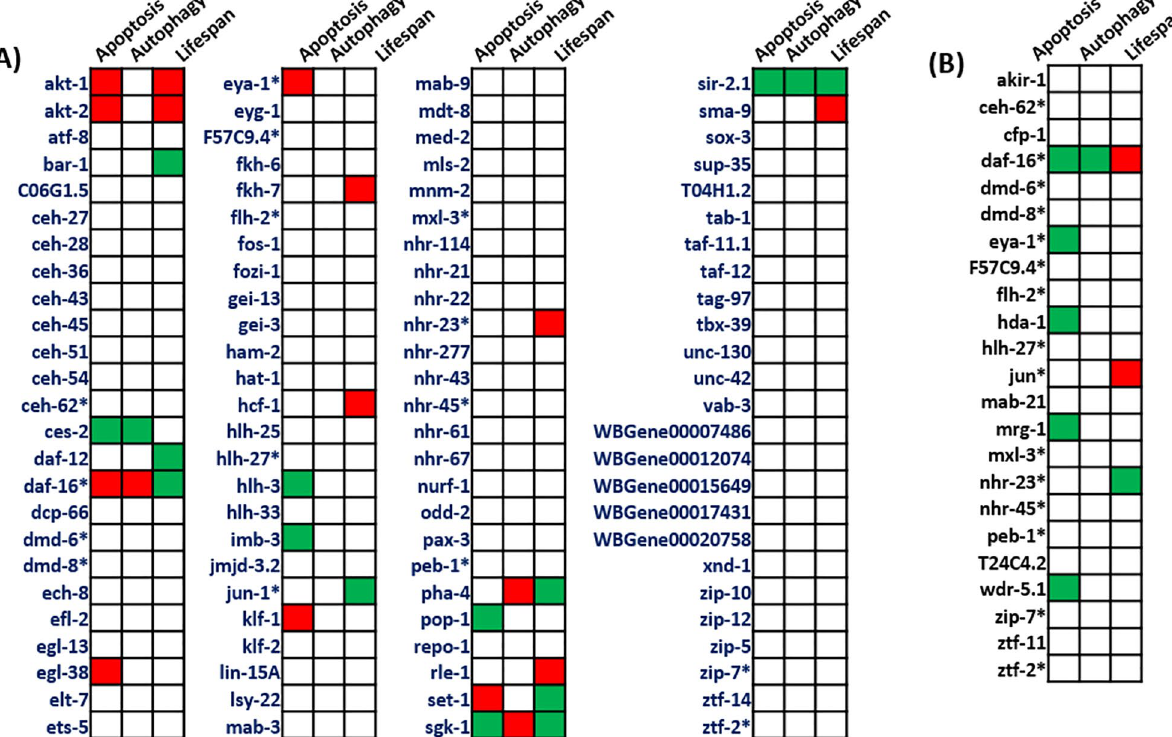
Figure 7. Analysis of SIN-3 protein interactome of mutants of C. elegans obtained from ( A ) GeneMANIA database and ( B ) direct evidence method using WormBase 107 phenotype option. Green indicates an increase, while red indicates a decrease in apoptosis/autophagy/ longevity of C. elegans